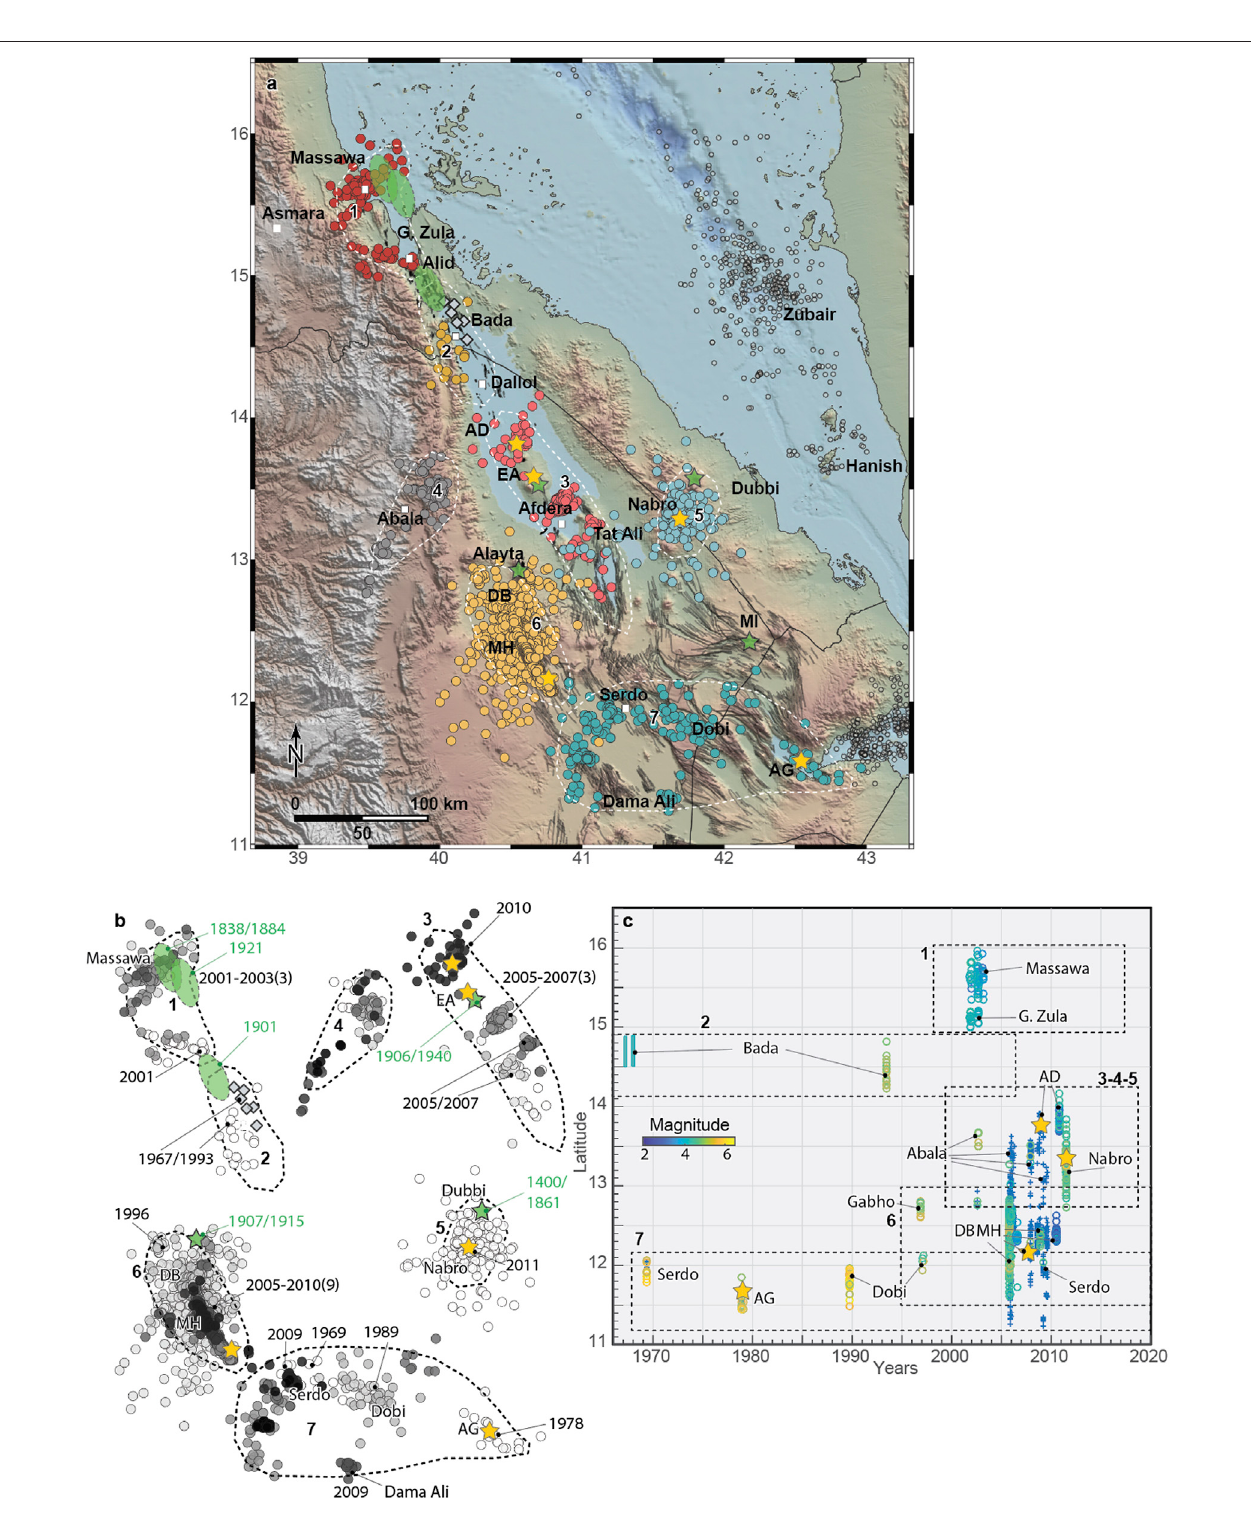
FIGURE 5 | Earthquake swarms in the Afar region from 1960 to 2017. (A) Seven different clusters were identi fi ed in the Afar region from Massawa (Eritrea) to Asal Ghoubbet (Djibouti). AD is for Alu Dala fi lla, EA Erta Ale,MH MandaHararo, MI Manda Inakir, AG Asal Ghoubbet. (B) Each cluster consists ofseveral earthquake swarms whose timing is indicated by the grey gradient from white (older events) to black (younger events). The larger swarms are marked by the year of occurrence with the number of swarms (in brackets) for the noted period. Green polygons and green stars represent historical swarms and eruptions, respectively. (C) Swarm latitude as a function of time for the different clusters, with colors showing event magnitudes and blue stars representing earthquakes with no magnitudes. Yellow stars show volcanic eruptions.